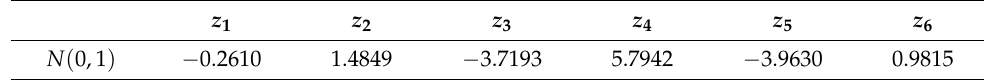
Table 5. Coefficients found in the second example by MM.